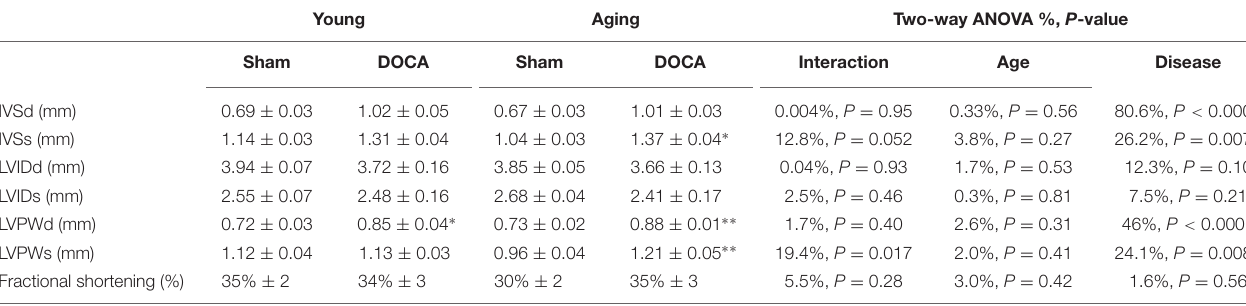
TABLE 1 | Serial echocardiographic examination in sham and DOCA mice between young and aging groups. Young Aging Two-way ANOVA %, P -value Sham DOCA Sham DOCA Interaction Age Disease